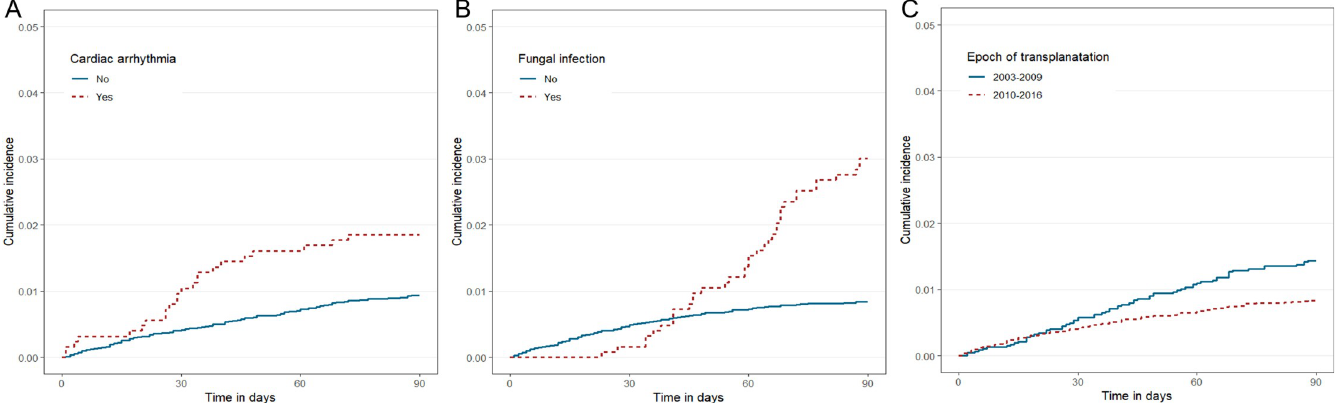
Fig 2. Cumulative incidence of mortality according to the factors associated 1- or 3-month mortality after kidney transplantation. (A) Cardiac arrhythmia was related to a worse outcome 1 month after transplantation. (B) Fungal infection were a risk factor of 3-month mortality after transplantation. (C) Recent epoch of transplantation (2010–2016) was a protective factor of 3-month mortality compared to the treatment-related mortality of previous epoch (2003–2009).